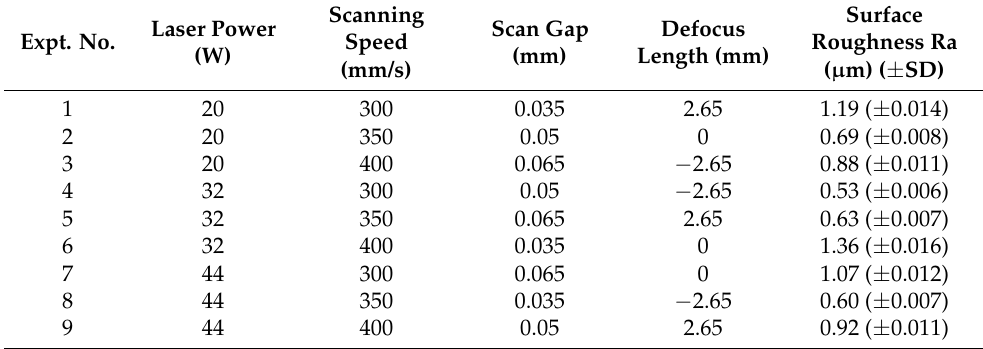
Table 3. Design matrix with Input factors and surface roughness as quality measure.